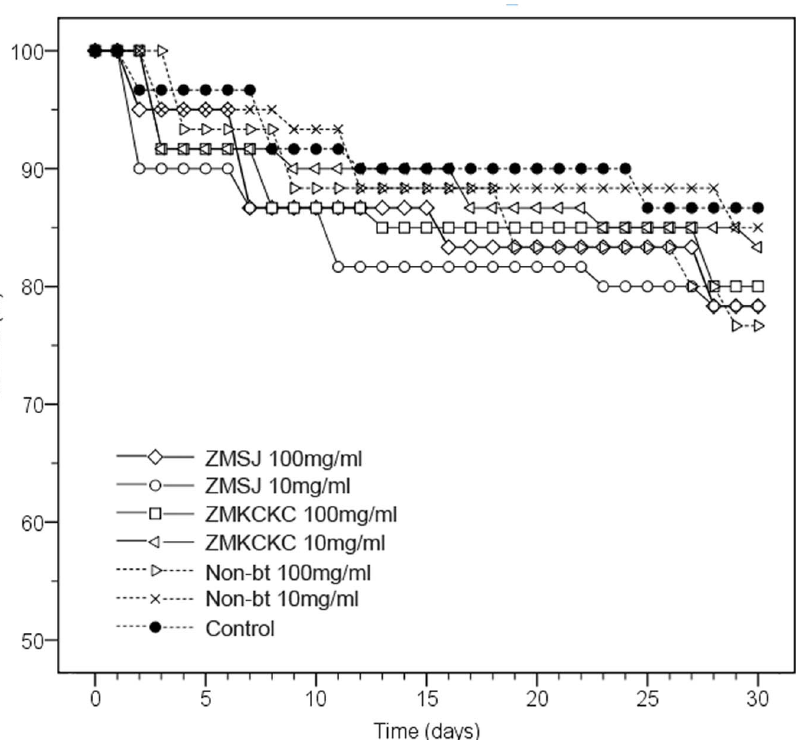
Figure 2. Survival analysis of silkworm larvae treated with different doses of Bt-pollen or non-Bt pollen. No significant differences in survival rates were found among all the treatments at the P . 0.05 level (followed by Kaplan–Meier survival analysis).